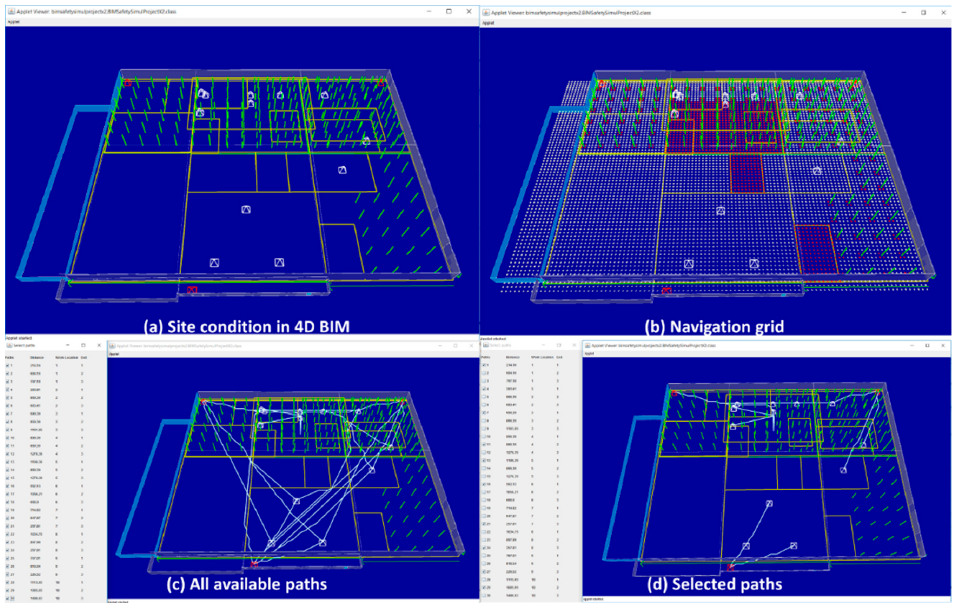
Figure 15. Scenario 2 ( a ) site condition, ( b ) navigation grid, ( c ) all available paths, and ( d ) selected paths.